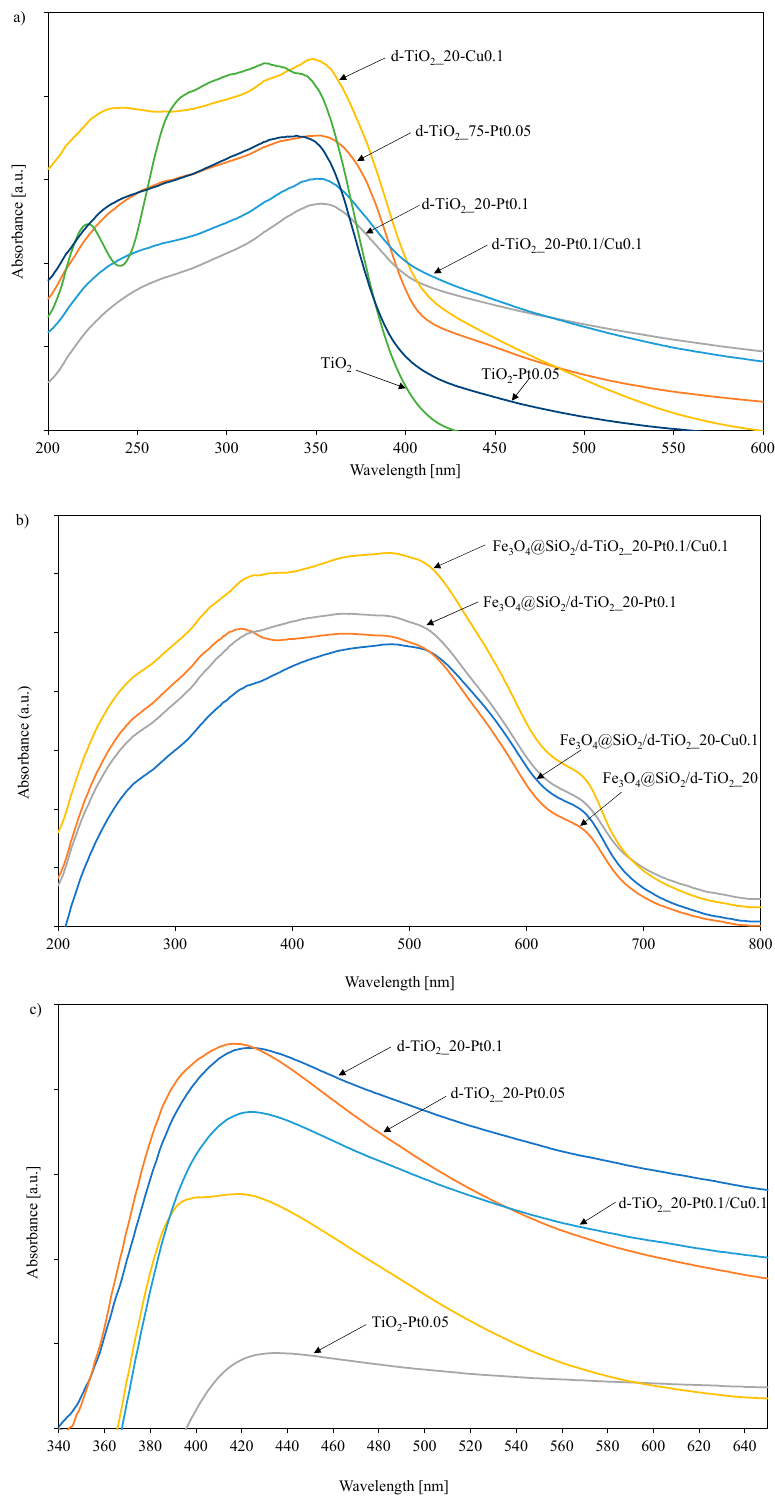
Figure 4. DR/UV-Vis spectra for selected d-TiO 2 -Pt/Cu ( a ) and Fe 3 O 4 @SiO 2 /d-TiO2-Pt/Cu ( b ) photocatalysts together with Pt and Cu plasmon determination with bare TiO 2 as a reference ( c ).